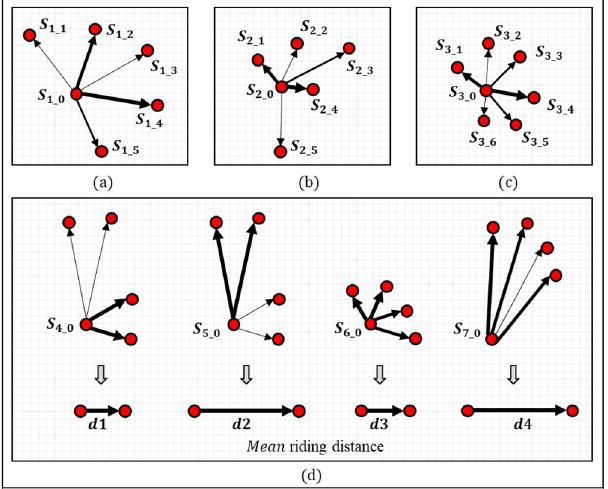
Figure 5. Heterogeneity of riding distance between different docking stations. ( a ) homogeneous long-distance and heterogeneous trips, ( b ) heterogeneous distance and heterogeneous trips, ( c ) ho- mogeneous short-distance and heterogeneous trips, ( d ) average distance in different composition pattern of origin-destination distance and trips.